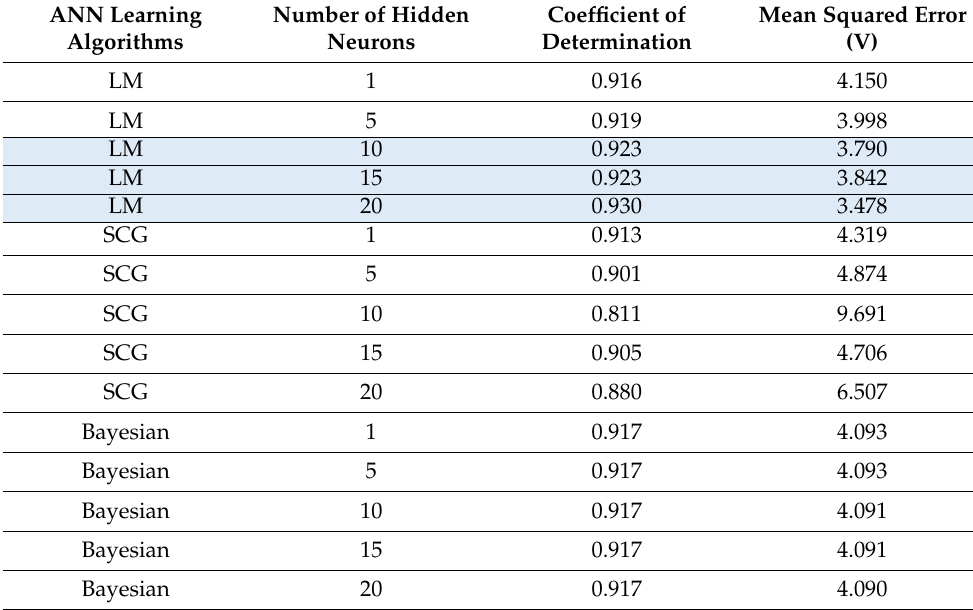
Table 2. Statistical analysis of the model results for the stack voltage.